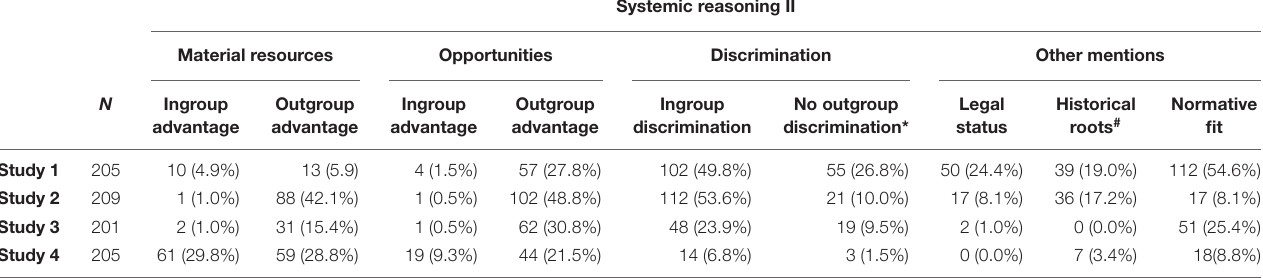
TABLE 5 | Content analysis of systemic status